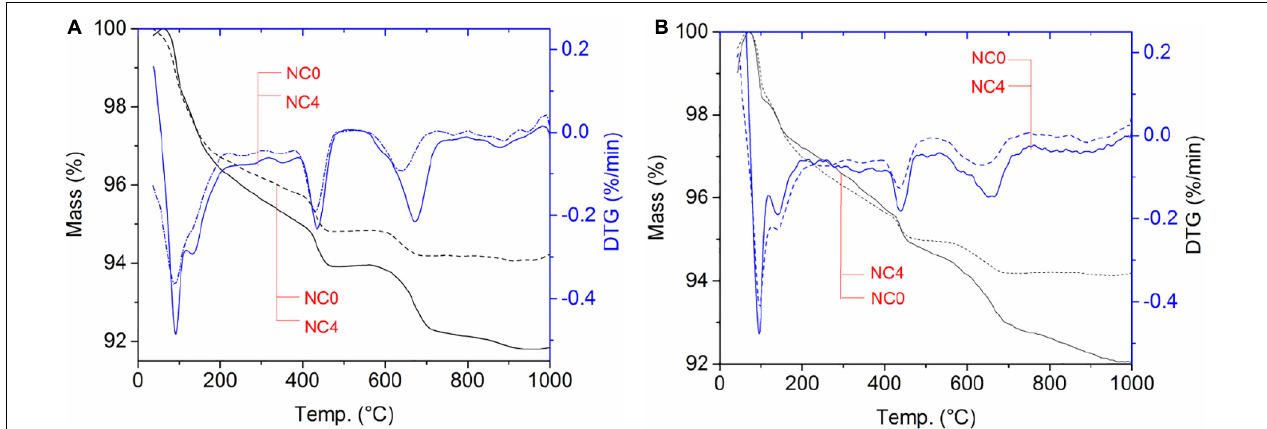
FIGURE 12 | Derivative thermogravimetry–thermogravimetry analysis of specimens at 7 and 90 days: (A) 7 days, (B) 90 days.